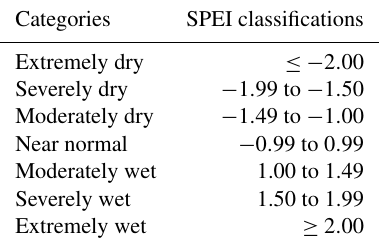
Table 1. Categories of dryness/wetness degree according to the SPEI values (McKee et al.,